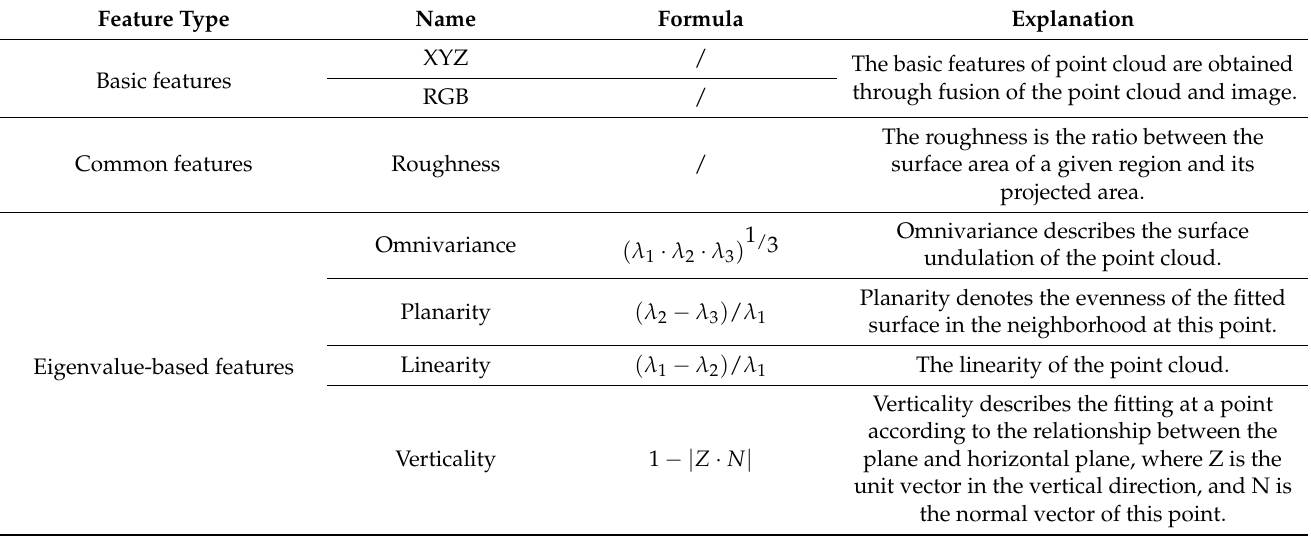
Table 1. Features for